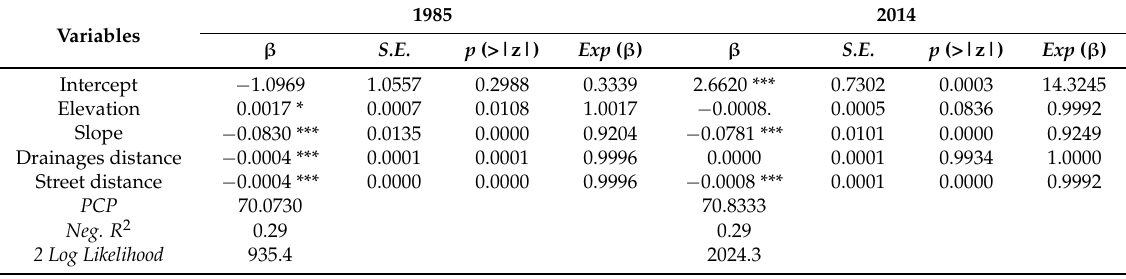
Table 5. Estimated results of the logistic regression model in Al-Taif of the four independent variables.